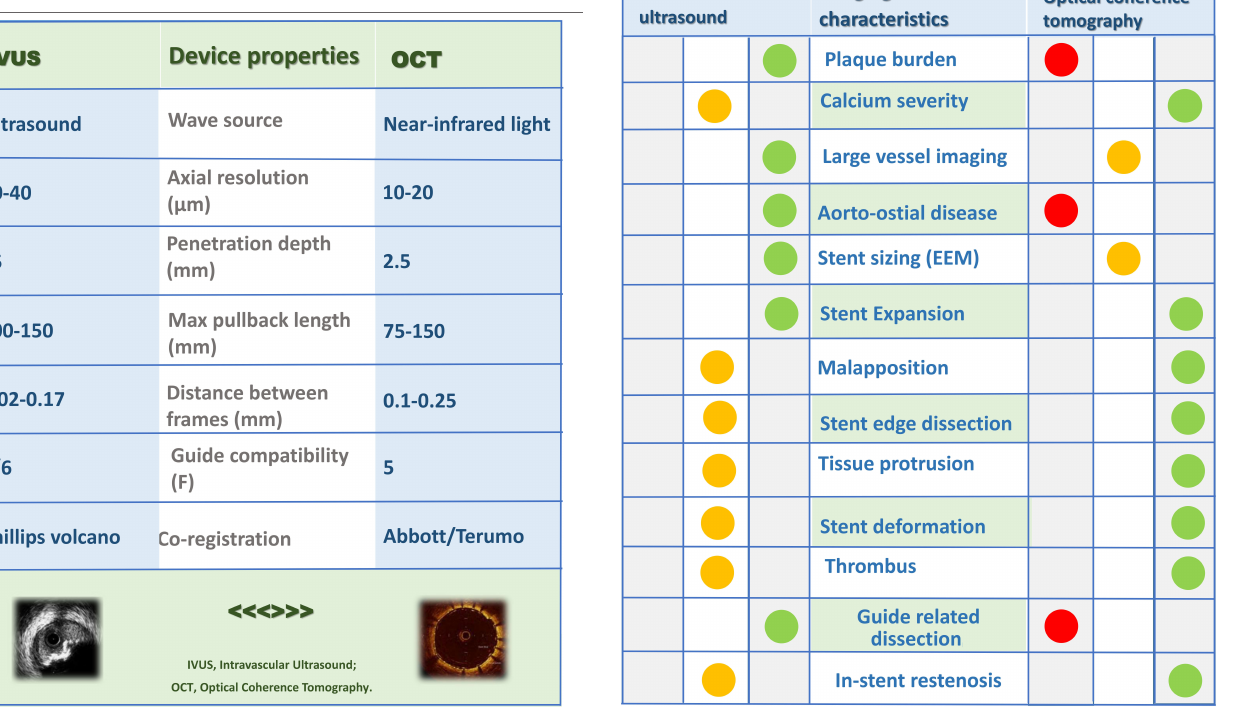
TABLE 1 | Intra-coronary imaging device characteristics.